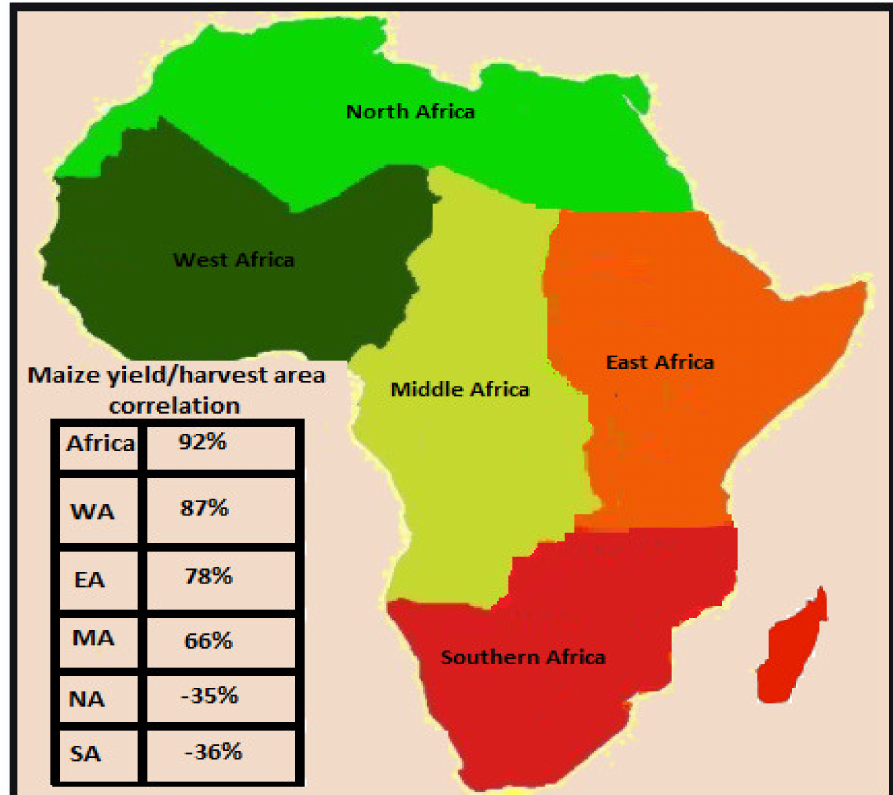
Figure 2. Correlation between maize yield and harvest area across different regions of Africa. Table 3. Correlation and coefficient of determination (R 2 ) between maize yield and harvest area. Correlation between Coefficient of Determination (R 2 ) between Maize Yield and Harvest Maize Yield and Harvest Area (%) Area (%) Africa